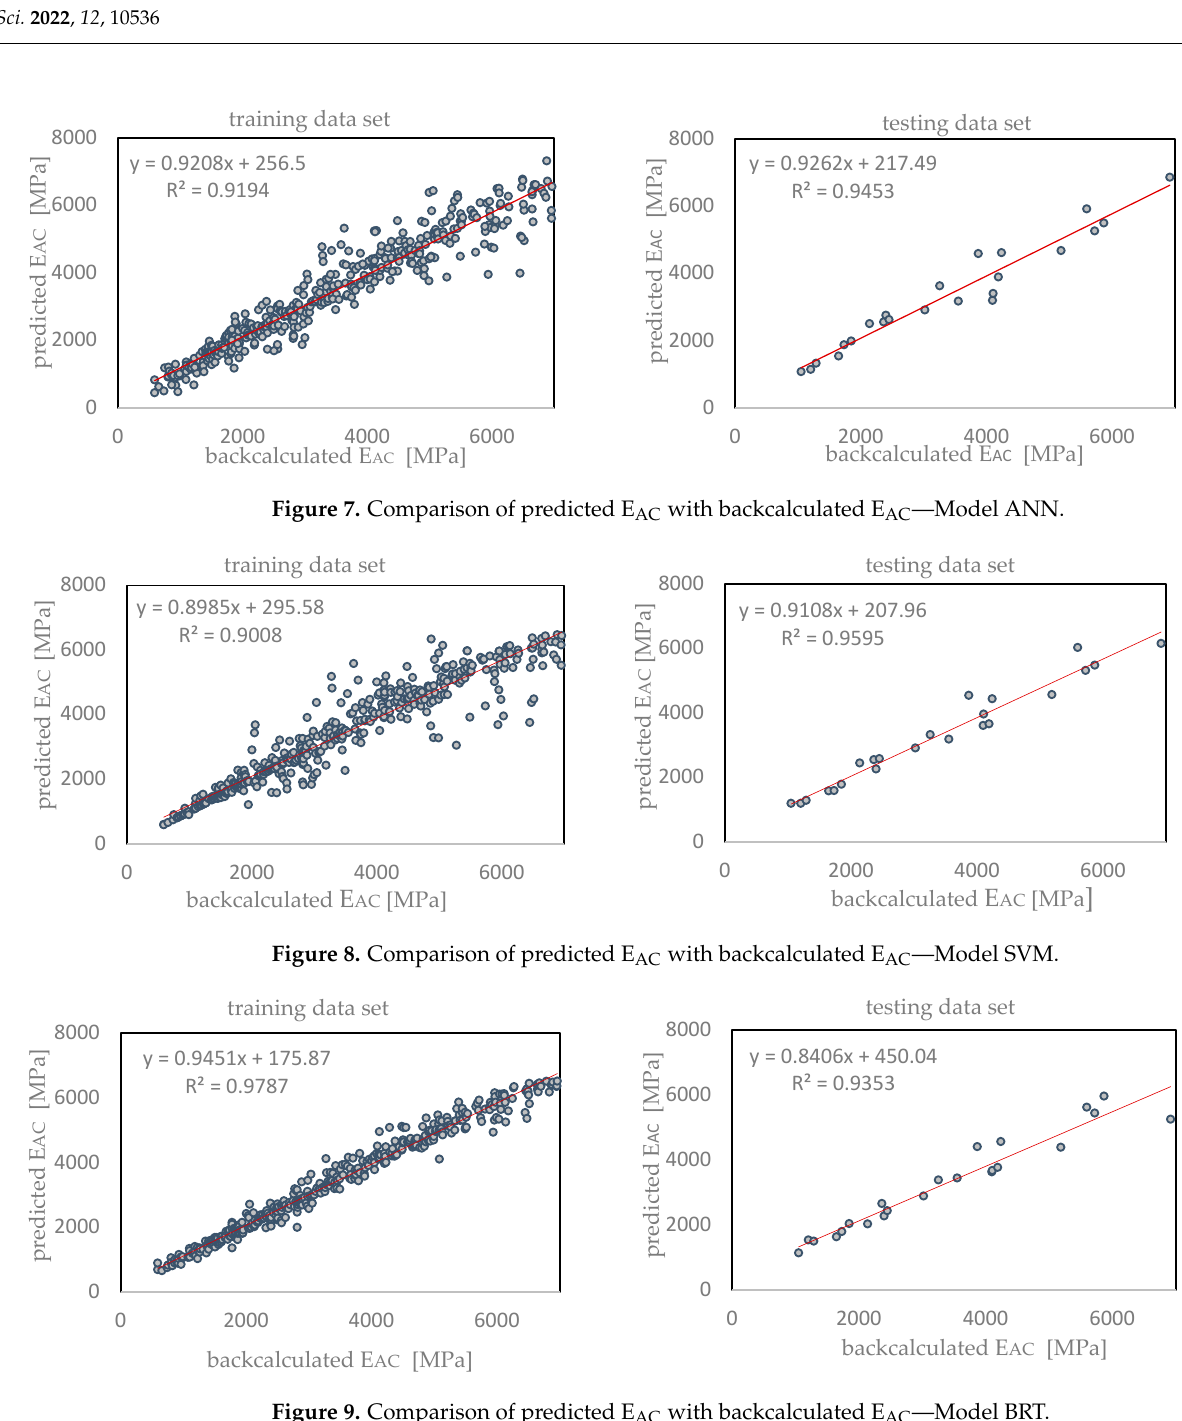
Figure 9. Comparison of predicted E AC with backcalculated E AC —Model BRT. Table 5. Comparison of model performance for predicted AC surface layer modulus (E AC ).